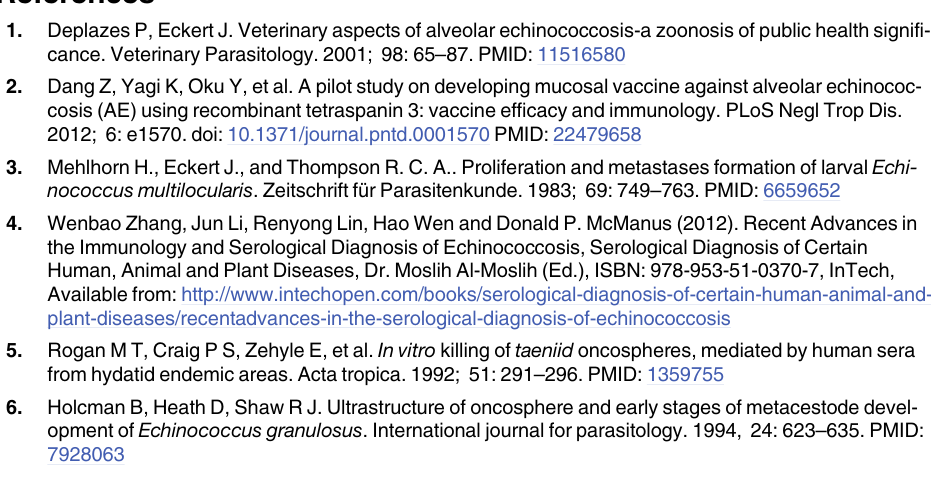
S1 Fig. IGV view of putative Em-TSP3 isoforms in pathogen_EMU_scaffold_007780 of E . multilocularis genome versions 3. The five tracks show the mapped result of EmuJ_001077300 (gene start: 13002559, gene end: 13003475) and EmuJ_001077400 (gene start: 13008382, gene end: 13009298) which all most reads can mapped to the two putative Em-TSP3 isoforms. At the locus of 13002639 and 13008462, there was two common single- nucleotide polymorphisms (SNPs) but the ratio of the two SNPs were obviously different among the samples. S1 Table. Nucleotide sequences of putative Em-TSP3. S2 Table. Significant different expressed genes in Non-activated oncospheres, Activted oncospheres and early stage of Metacestodes from Echinococcus multilocularis (P < 0.01, FDR < 0.05). S3 Table. Transcript data of dignostic antigen gp50 family in any of the sampled life cycle stage in this study and previous report [23]. S4 Table. BLASTX results of putative Em-TSP3 isoforms from different